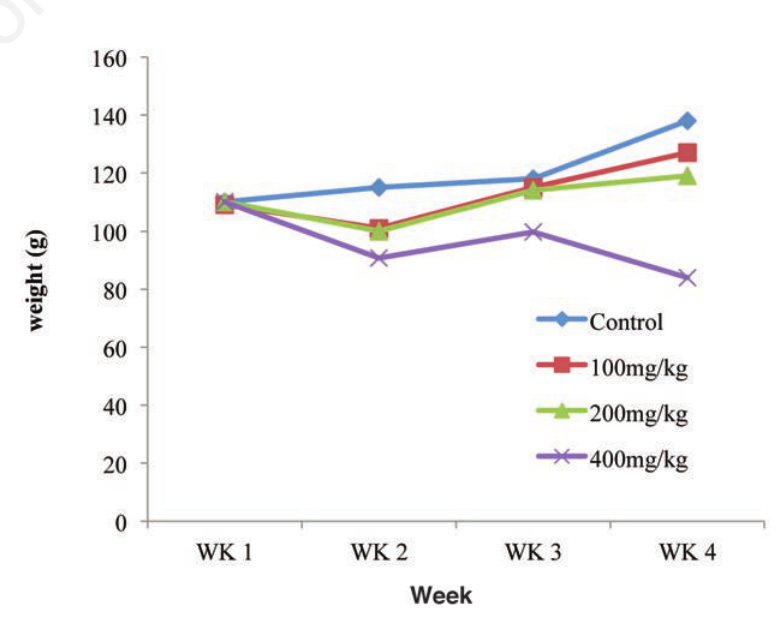
Figure 1. Effect of oral administration of Solignum ® on body weight changes in control and treated